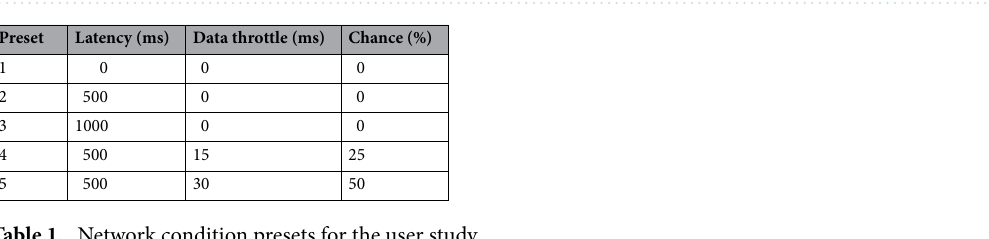
Table 1. Network condition presets for the user